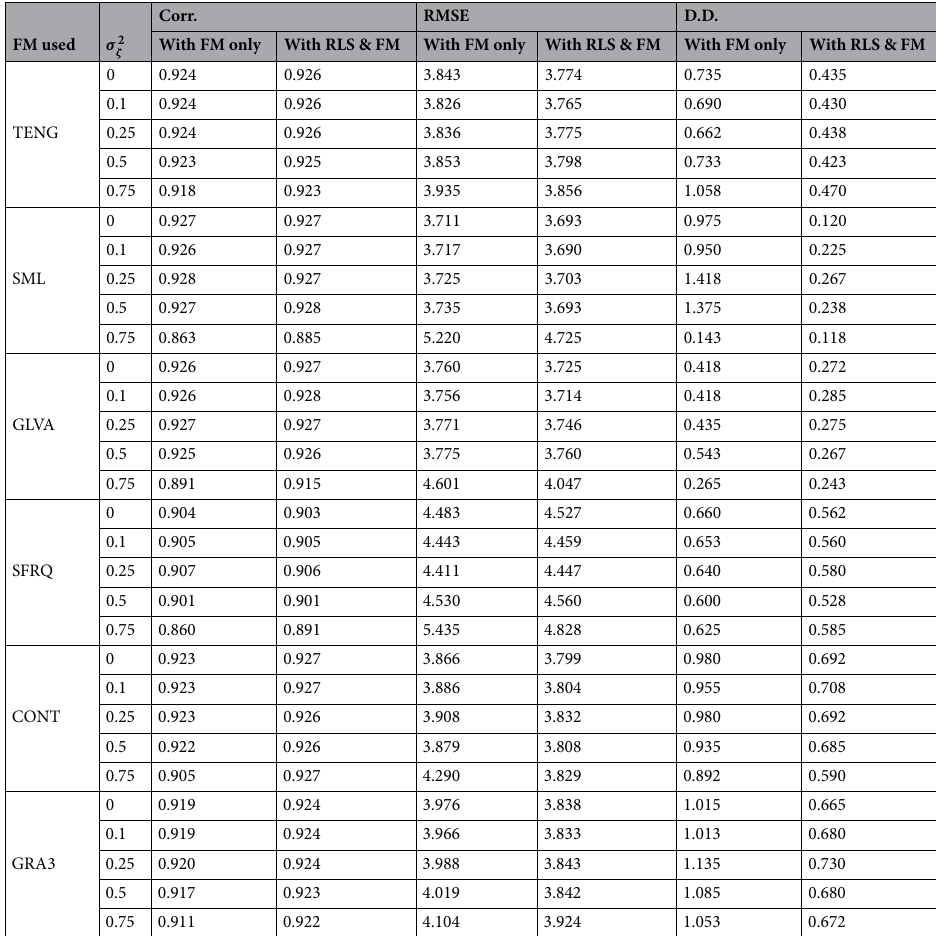
Table 10. RMSE Correlation (Cor.) and Depth Distortion (D.D. in %) Metrics for Real Cone shape reconstruction using FMs with different levels of variance of Jitter noise σ 2 ξ = ( 2 ak + b ) 2 σ 2 ζ + 2 a 2 σ 4 ζ